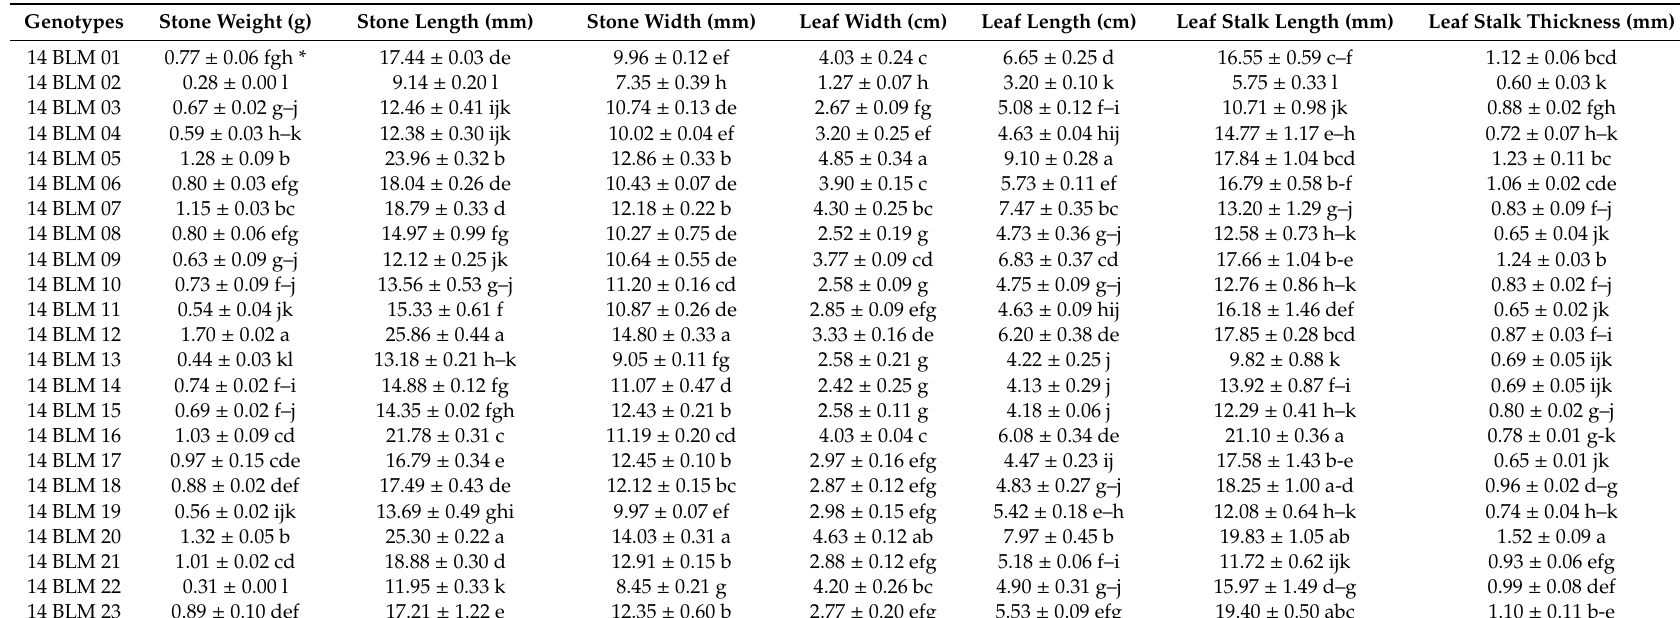
Table 2. Stone and leaf characteristics of plum